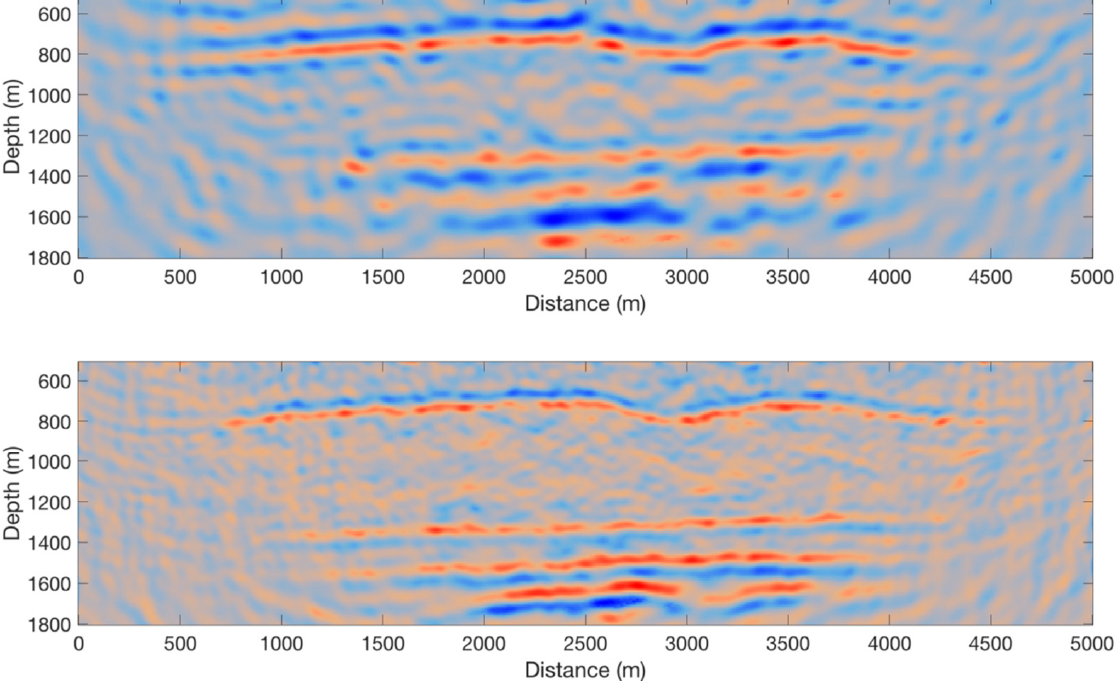
(cid:0) (cid:1) I p , I s